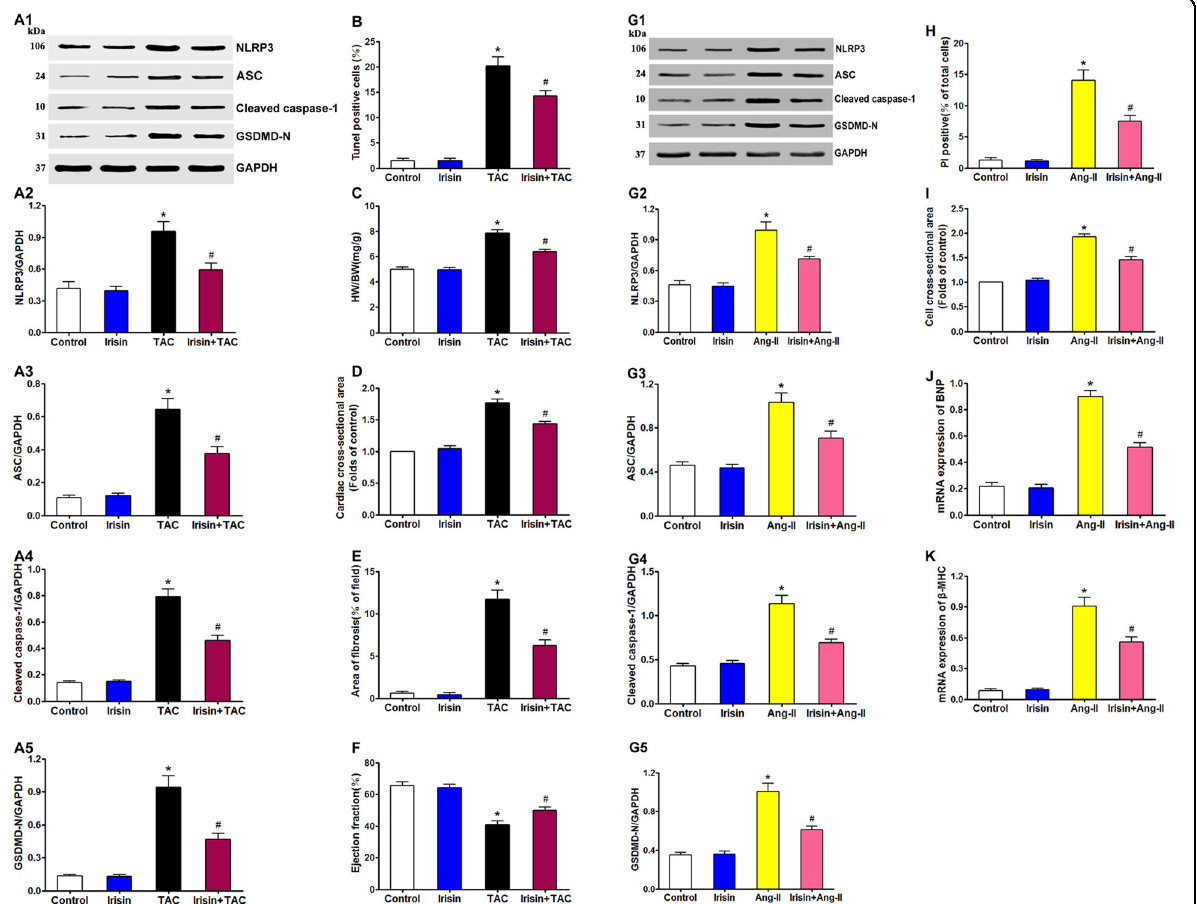
Fig. 4 Irisin inhibits overload-stimulated pyroptosis and ameliorates cardiac hypertrophy and cardiac function. A Immunoblots showing protein levels of NLRP3 ( A1 , A2 ), ASC ( A1 , A3 ), cleaved caspase-1 ( A1 , A4 ), and GSDMD-N ( A1 , A5 ) in the indicated groups. B Percentage of TUNEL- positive cells in the indicated groups. C Proportion of heart to body weight in the indicated groups. D Quanti fi cation of the cross-sectional area of cardiomyocytes of the left ventricle in the indicated groups. E Quanti fi cation of the myocardial fi brosis in the indicated groups. F Quantitative analysis of left ventricular EF in the indicated groups. G Immunoblots showing protein levels of NLRP3 ( G1 , G2 ), ASC ( G1 , G3 ), cleaved caspase-1 ( G1 , G4 ), and GSDMD-N ( G1 , G5 ) in the suitably treated cardiomyocytes. H Percentage of PI-positive cells in the suitably treated cardiomyocytes. I Measurement of the cell surface area of cardiomyocytes in the indicated groups. mRNA expression of cardiac hypertrophy markers BNP ( J ) and β -MHC ( K ) in the suitably treated cardiomyocytes. Results are presented as the mean ± SEM, n = 6. ∗ P < 0.01 compared to control, # P < 0.01 compared to TAC group or Ang-II